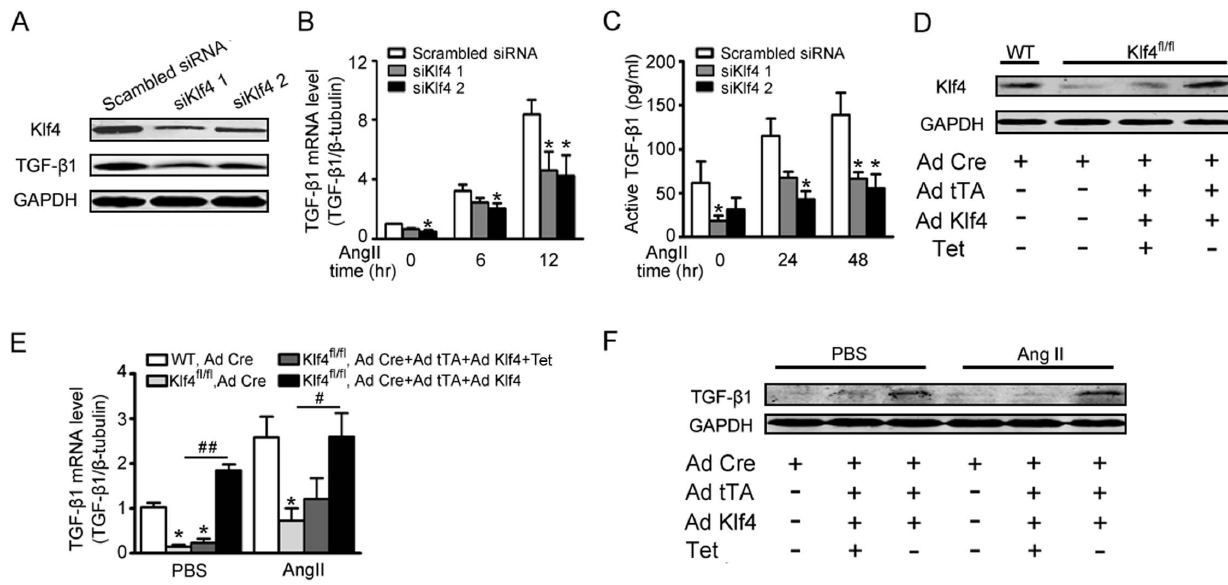
Figure 5. Ang II-induced TGF- b 1 production is partly dependent on Klf4. A–C, cardiac fibroblasts were transfected with siKlf4 and treated with Ang II. A, Western blot showed siRNA-mediated knockdown of Klf4 and TGF- b 1 protein levels in cardiac fibroblasts. B, TGF- b 1 mRNA levels were assessed by qPCR after Ang II treatment for 0, 6 or 12 hrs (n=3). C, ELISA was used to analyze active TGF- b 1 levels in the supernatant of Klf4- or scrambled-siRNA transfected cardiac fibroblasts after Ang II treatment for 0, 24 or 48 hrs (n=3). *P , 0.05 vs. scrambled siRNA. D–F, adult cardiac fibroblasts were isolated from mice carrying LoxP floxed Klf4 alleles. The cells were infected with Ad-Cre for Klf4 deletion, and infected WT cells were served as the negative control. Ad-Cre, Ad-tTA and Ad-Klf4 were co-infected to reintroduce Klf4 expression. D, 2 days after adenovirus infection, the cells were analyzed for Klf4 protein expression by Western blot. E, TGF- b 1 mRNA levels were assessed by qPCR after Ang II treatment for 0 or 6 hrs in Klf4-deleted and Klf4-reintroduced fibroblasts and were normalized to b -tubulin (n=3). Data are the mean 6 SEM. *P , 0.05 vs. Ad-Cre infected WT control; # P , 0.05, ## P , 0.01 vs. Ad-Cre infected Klf4-floxed fibroblasts. F, TGF- b 1 protein levels were assessed by Western blot after Ang II treatment for 24